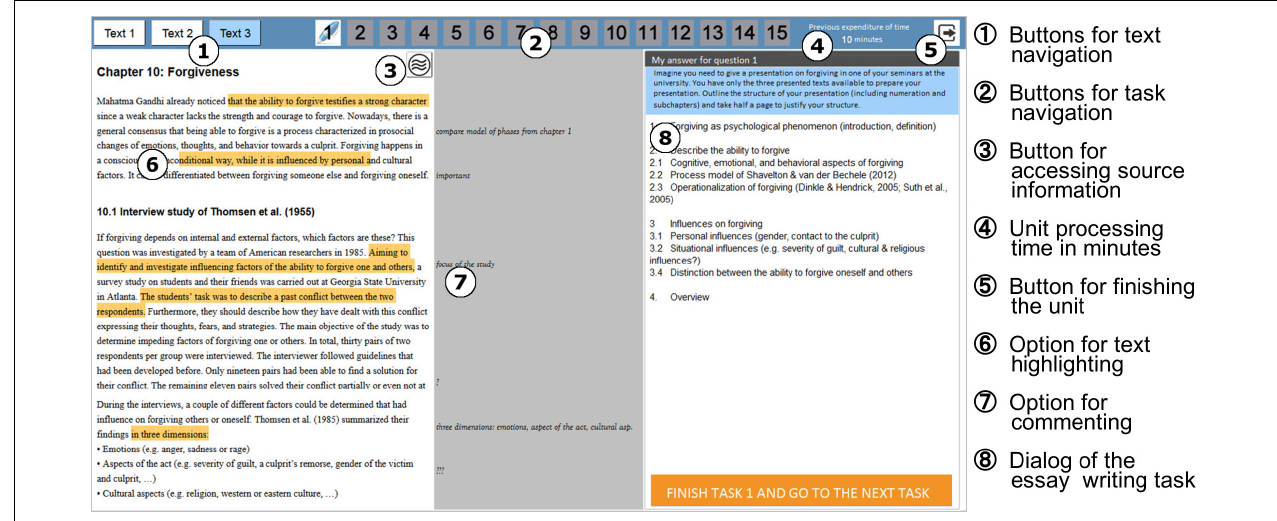
FIGURE 2 | Example of an MDC unit. Source: Hahnel et al. (2019a). Validating process variables of sourcing in an assessment of multiple document